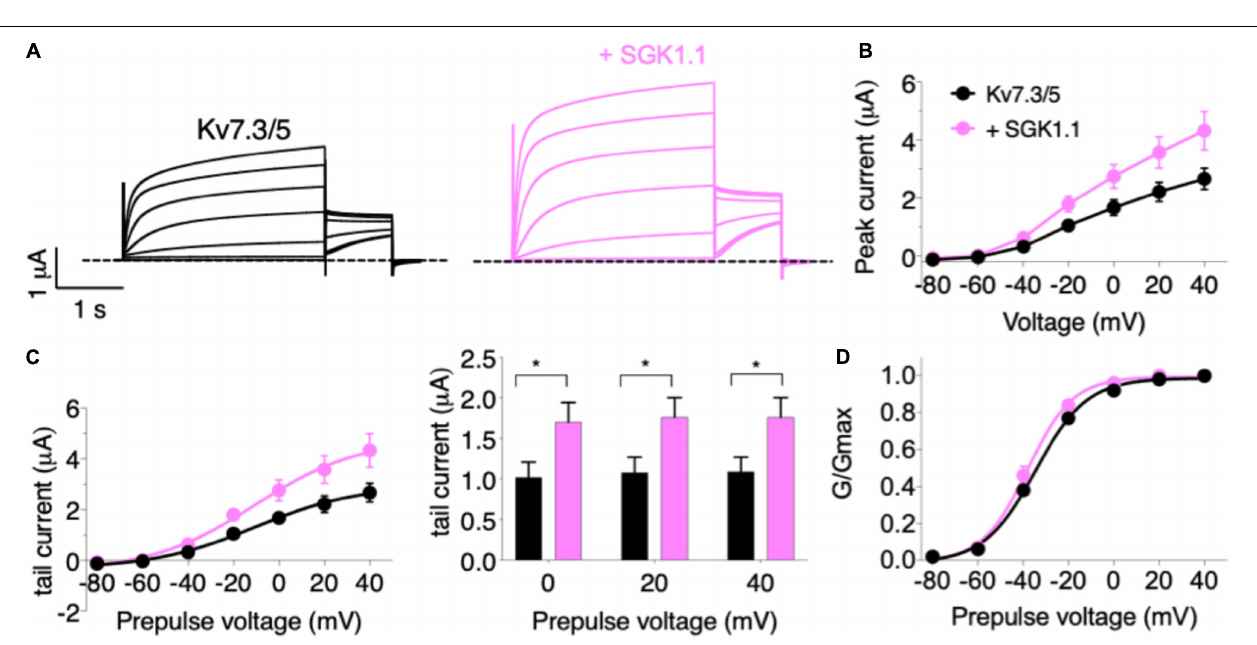
FIGURE 1 | Wild-type and activated SGK1.1 upregulate M-current. (A) Currents elicited in Xenopus oocytes after coinjection of cDNAs from Kv7.2/3 channel alone (first panel) or in combination with wild-type (second panel) or constitutively active (third panel) SGK1.1. (B) Peak current/voltage relationship. (C) Tail current (left) and tail currents measured at –30 mV after 0, + 20 or + 40 mV depolarizing pulses for the indicated construct combinations (right). Values represent mean ± SEM. Two-way ANOVA followed by Tukey’s correction for multiple comparisons, **** p < 0.0001. (D) Normalized conductance. Legends are indicated on (B) .